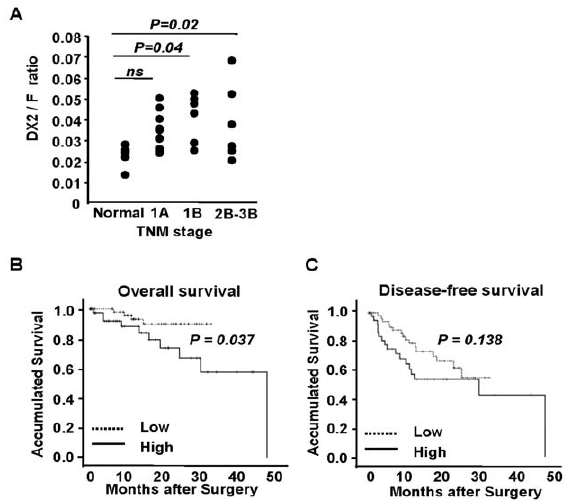
Figure 8. Correlation of expression ratio of AIMP2-DX2 to AIMP2-F with lung cancer stage and survival. (A) AIMP2-DX2/F ratios of patient tissues with cancer stage IA (n=5), IB (n=6) and IIB , IIIB (n=7) were compared with that of normal lung tissues (n=5) by quantitative RT-PCR method as described. The ratios were increased significantly (p , 0.05) according to tumor progression. Cancer stages were classified based on TNM (tumor, nodes, metastasis) system. Kaplan-Meier estimates of the (B) OS and (C) DFS according to the level of the expression ratios of AIMP2-DX2 to AIMP2-F in 97 lung cancer patients. The OS was significantly worse in patients with higher expression ratio of AIMP2-DX2 to AIMP2-F than in patients with lower expression ratio. P- values were calculated by the log-rank test.